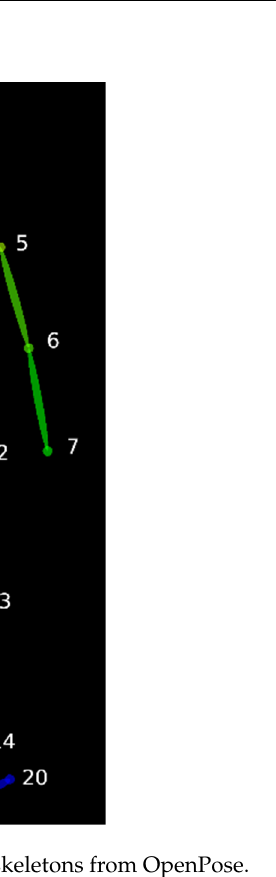
Figure 1. Output keypoint skeletons from OpenPose.